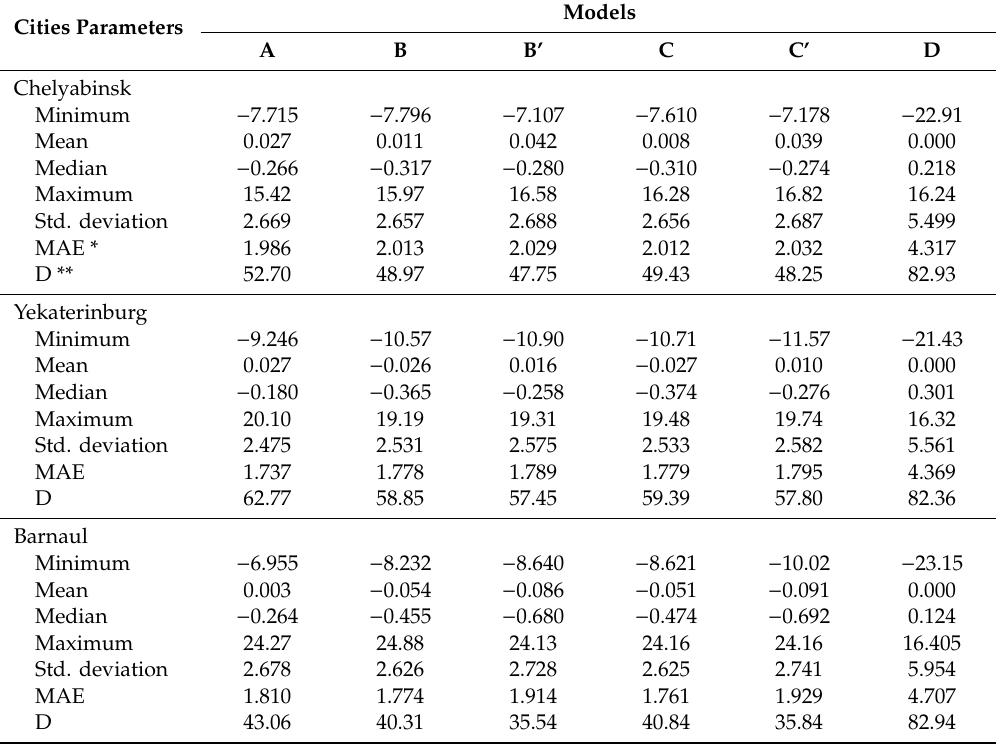
Table 3. Accuracy of model identification based on statistical characteristics of model residuals.